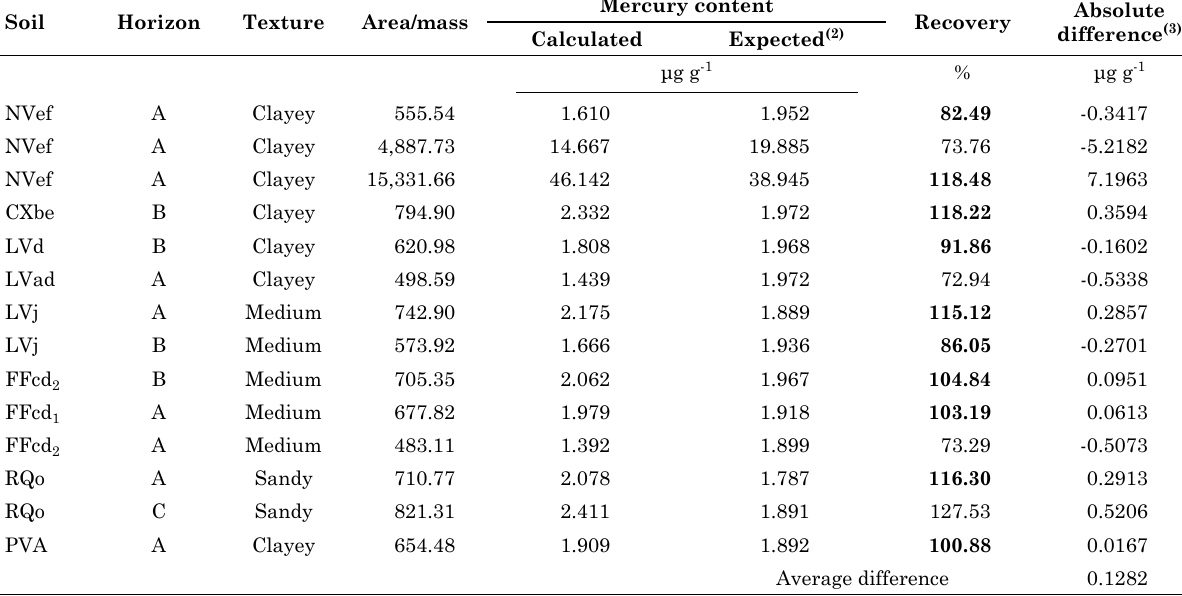
table 5. Mercury levels determined by thermal desorption associated with atomic absorption spectrometry in lyophilized soil samples after hg 2+ adsorption experiments, and the contents estimated by the DMa in the supernatants from the same experiment